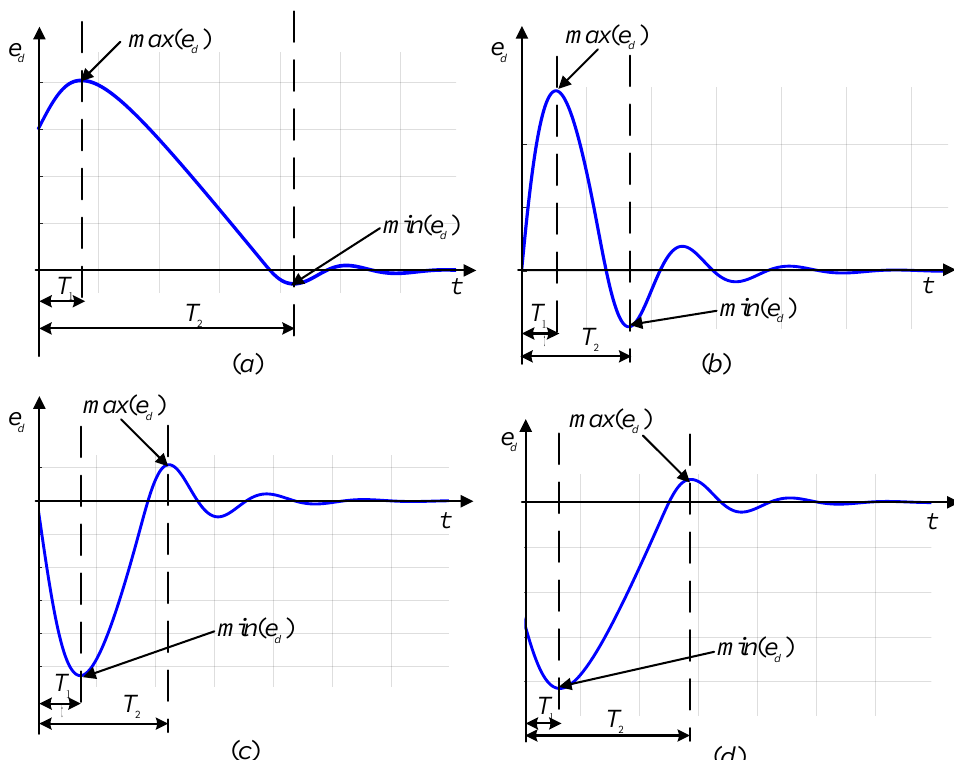
Figure 5. Four typical trajectories of e d . ( a ) e d 0 > 0; ( b ) e d 0 = 0 and e χ 0 ≥ 0; ( c ) e d 0 = 0 and e χ 0 < 0; ( d ) e d 0 < 0.